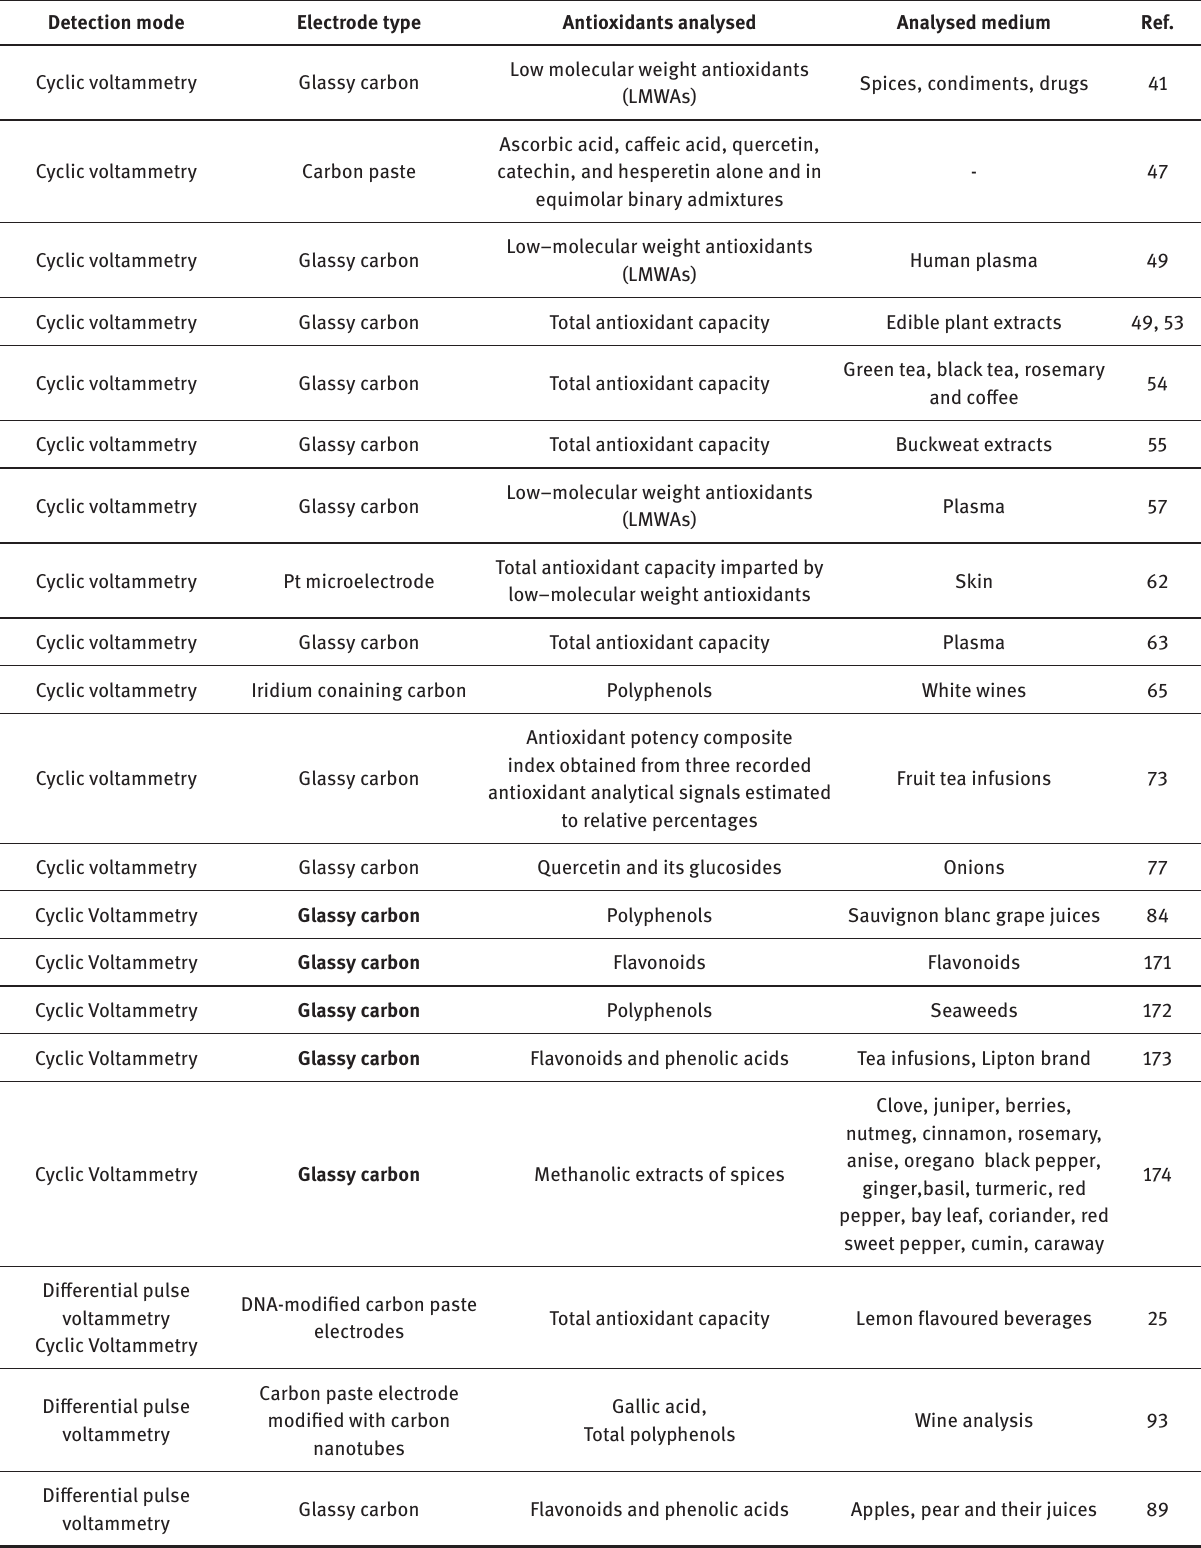
Table 2: Some applications of electrochemical methods for the determination of antioxidant capacity and its main contributors in various analysed